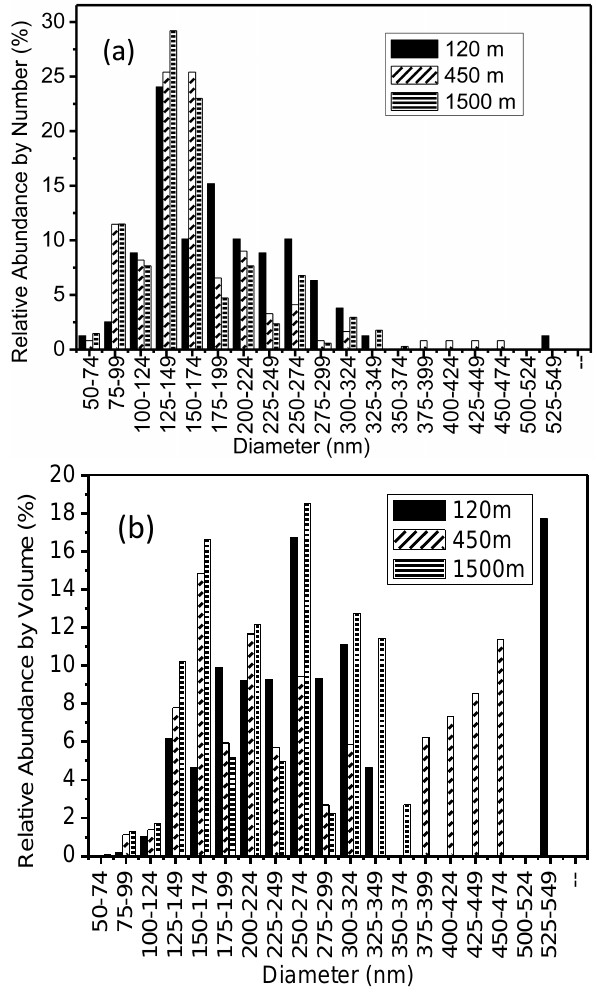
Fig. 10. Relative abundance by number (a) and volume (b) versus diameter for amorphous carbonaceous spheres collected from three altitudes. The relative abundance only considers the brown carbon. The average diameters of the brown carbon spheres weighted by number are 200, 170 and 160nm for 120, 450 and 1500m, respec- tively. The average diameters of the brown carbon spheres weighted by volume are 290, 280 and 235nm for the three